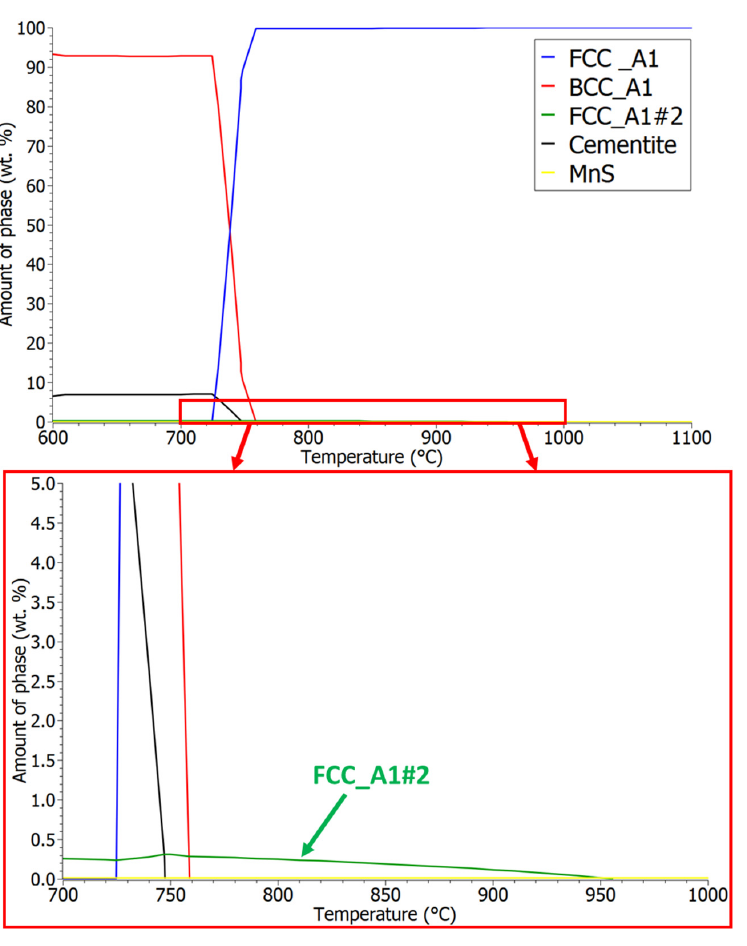
Figure 2. The equilibrium phase composition of 51CrV4 steel between 600 and 1100 °C.